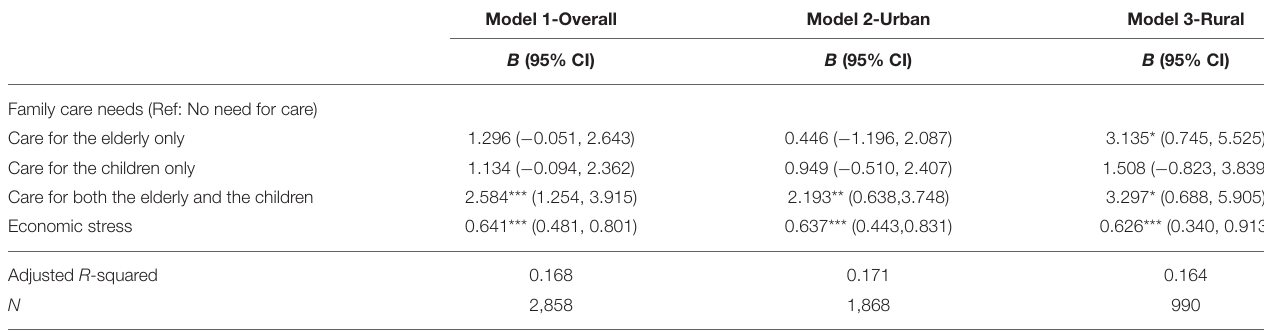
TABLE 2 | Multiple liner regression analysis of the relationship between family care needs, economic stress and depressive symptoms.